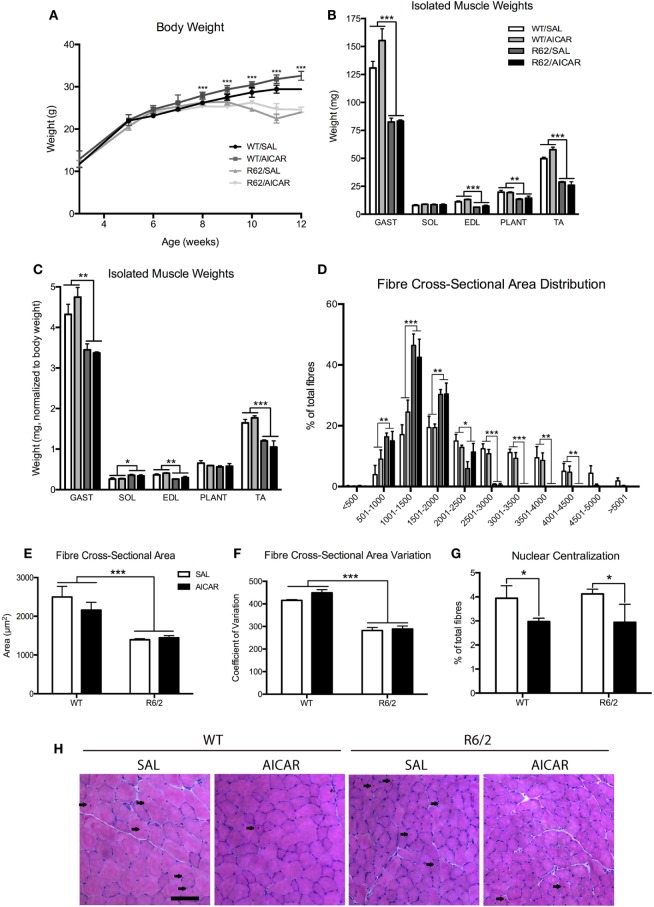
R6/2 mice show muscle atrophy. (A) Body weight in SAL- or 5-aminoimidazole-4-carboxamide-1-β-d-ribofuranoside (AICAR)-treated wild-type (WT) and R6/2 mice. Note that significant effects of age are omitted in the interest of clarity. R6/2 animals were significantly smaller than WT controls beyond 8 weeks of age. (B) Isolated muscle weights. GAST, gastrocnemius; SOL, soleus; EDL, extensor digitorum longus; PLANT, plantaris; TA, tibialis. GAST, EDL, PLANT, and TA were significantly smaller in R6/2 animals. (C) Isolated muscle weights, normalized to body weight. GAST, EDL, and TA were significantly smaller in R6/2 animals. (D) Distribution of fiber cross-sectional area, expressed as a percentage of total fibers included in 500 µm brackets. R6/2 animals had significantly fewer large fibers. (E) Quantification of total fiber cross-sectional area. R6/2 animals had significant fiber atrophy. (F) Coefficient of variation of the cross-sectional area. R6/2 animals had significantly less variation in fiber size. (G) Quantification of centralized nuclei, expressed as a percentage of total fibers. AICAR decreased the percentage of fibers with central nucleation. (H) Representative images of hematoxylin and eosin staining in TA muscle cross-sections. Scale bar indicates 100 µm, centralized nuclei indicated with arrows. Data shown as mean ± SEM, n = 3–8; *P < 0.05, **P < 0.01, ***P < 0.001.